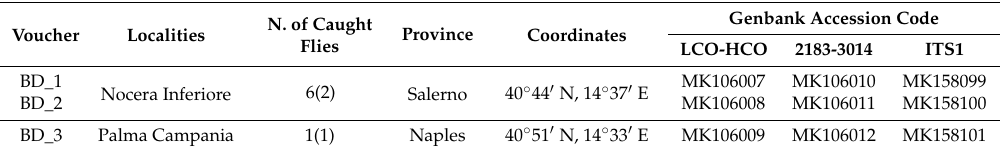
Table 1. Number of males collected in traps baited with methyl-eugenol grouped according to the locality of sampling. The numbers in brackets indicate the specimens whose COI and ITS1 were